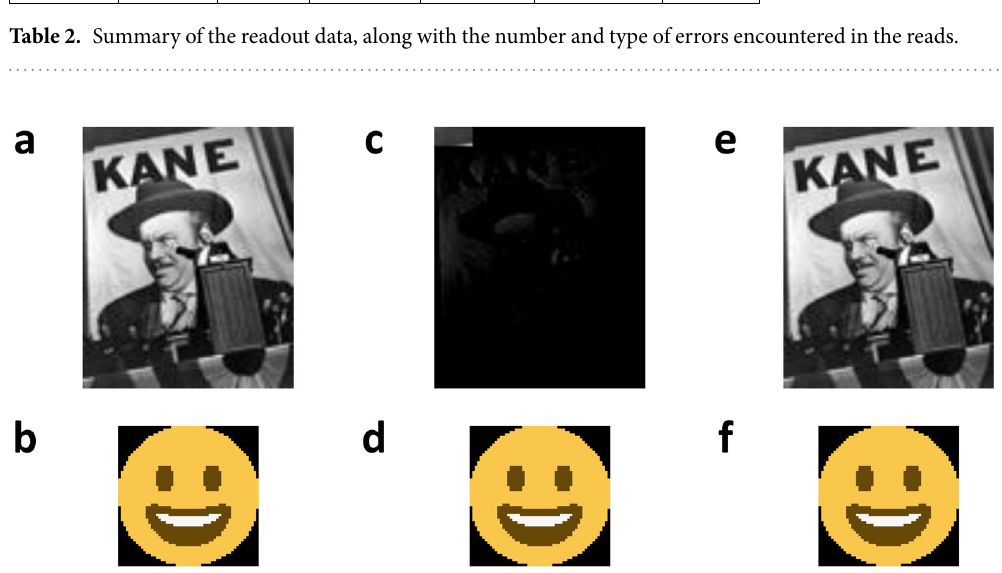
Figure 3. Image files used in our experiment. ( a , b ) show the raw images which were compressed, encoded and synthesized into DNA blocks. The Citizen Kane poster 19 (photographed by Kahle, A., date of access: 17/11/2016) RKO Radio Pictures, not copyrighted per claim of Wikipedia repository) and Smiley Face emoji were of size 9,592 and 130.2 bytes, and had dimensions of 88 × 109 and 56 × 56 pixels, respectively. ( c , d ) show the recovered images after sequencing of the DNA blocks and the post-processing phase without homopolymer error correction. Despite having only two errors in the Citizen Kane file, we were not able to recover any detail in the image. On the other hand, one error in the Smiley Face emoji did not cause any visible distortion. ( e , f ) show the image files obtained after homopolymer error correction, leading to an error-free reconstruction of the original